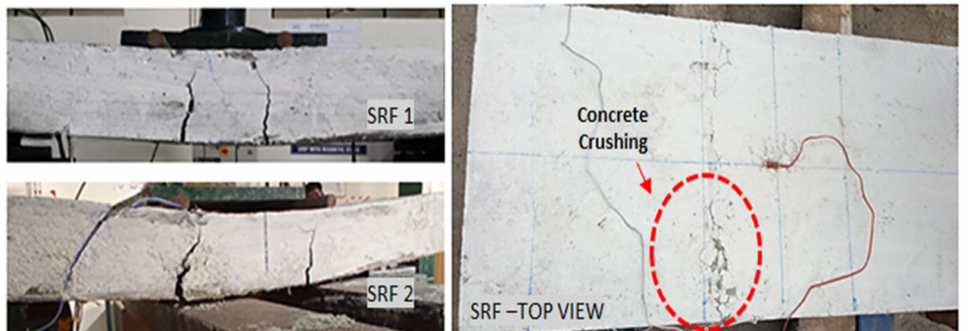
Figure 3. Crack pattern and failure mode of SRC slab.